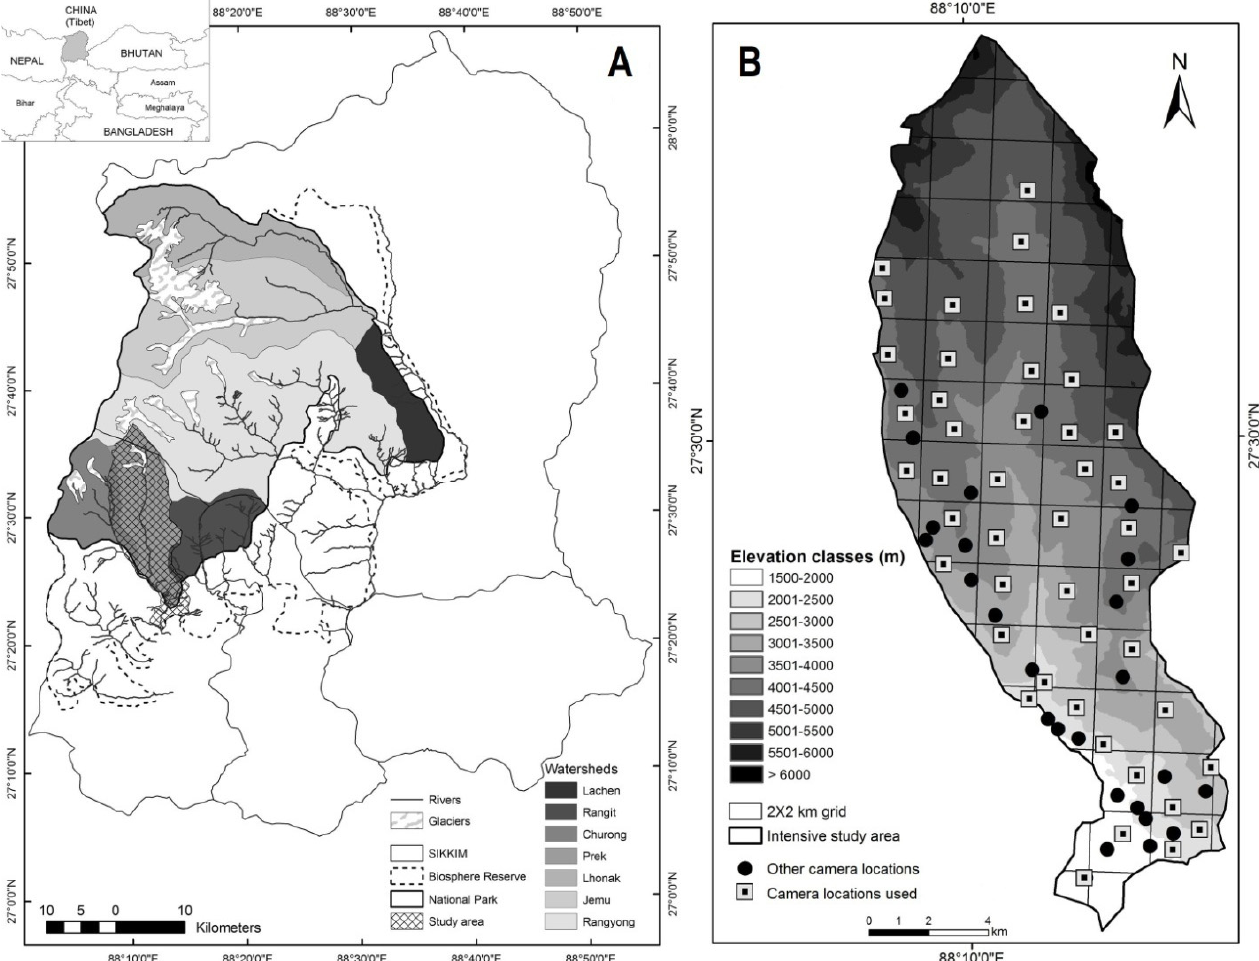
Figure 1. Location of Khangchendzonga Biosphere Reserve in Sikkim: ( A ) the inset’s shaded region indicates the positioning of Sikkim in north-east India, showing the National Park and the seven watersheds, including the Prek catchment (study area); ( B ) digital elevation model (DEM) of the Prek catchment showing locations of cameras deployed in the area.